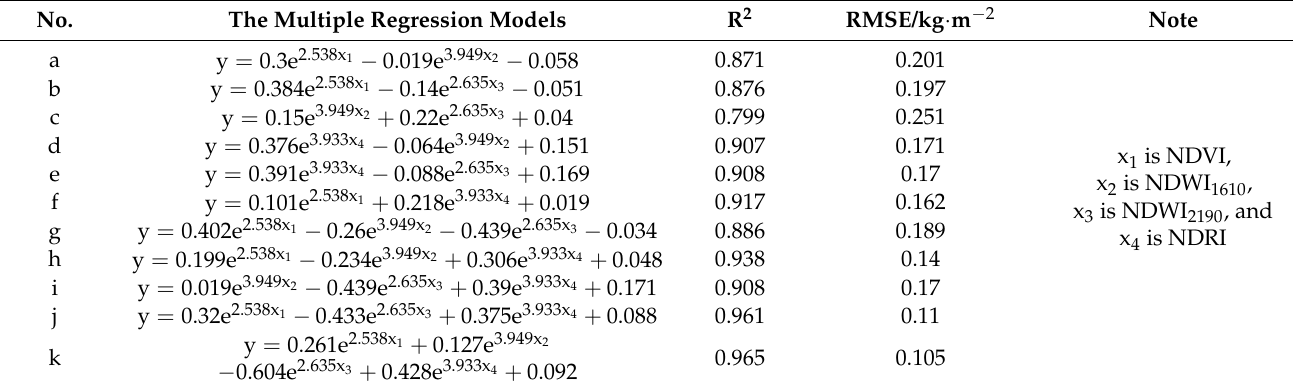
Table 2. Correlations between the modified VWC estimation models and the in situ measured VWC data. No. The Multiple Regression